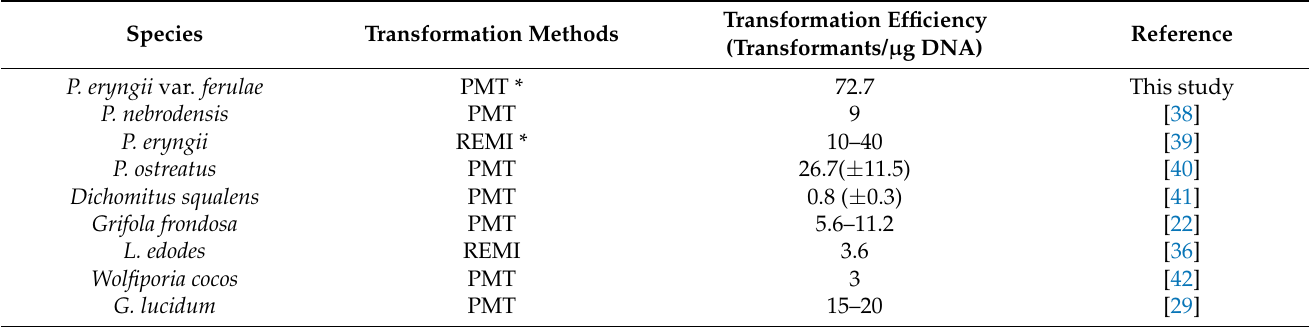
Table 1. Summary of protoplast-mediated transformation protocols for different fungal species. Transformation Efficiency Transformation Methods (Transformants/ µ g